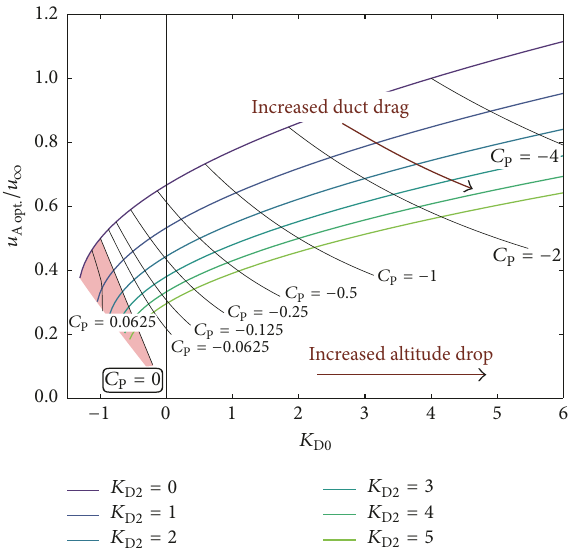
/𝑢 ≡ 𝑢 /𝑢 | ∞ ∞ 𝜂 load =1 as Aopt . A and drag coefficient 𝐾 D 0 D 2 = 𝐴 . Isocurves for various values of 𝐶 are f A P